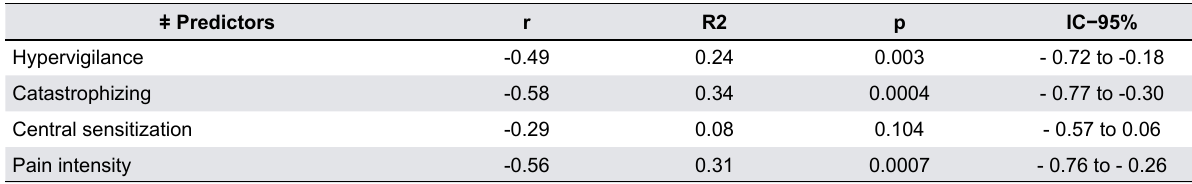
Table 5- Backward stepwise multiple linear regression analysis for the dependent variable, cognitive performance [measured using the Montreal Cognitive Assessment (MoCA) questionnaires; n=33] Model